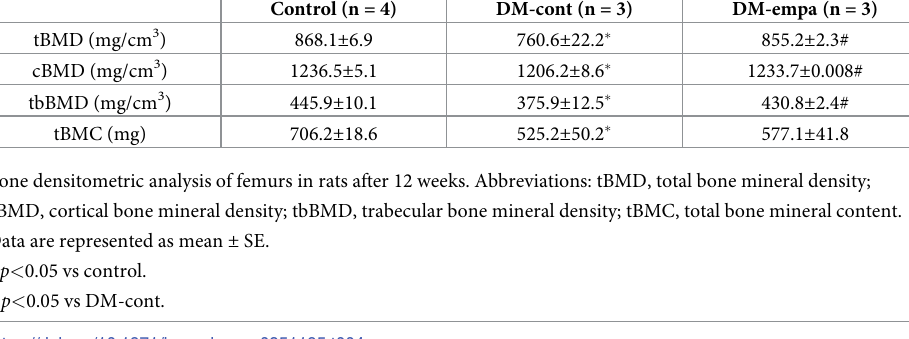
Table 4. Comparison of bone densitometry between control, DM-cont, and DM-empa. Control (n = 4)